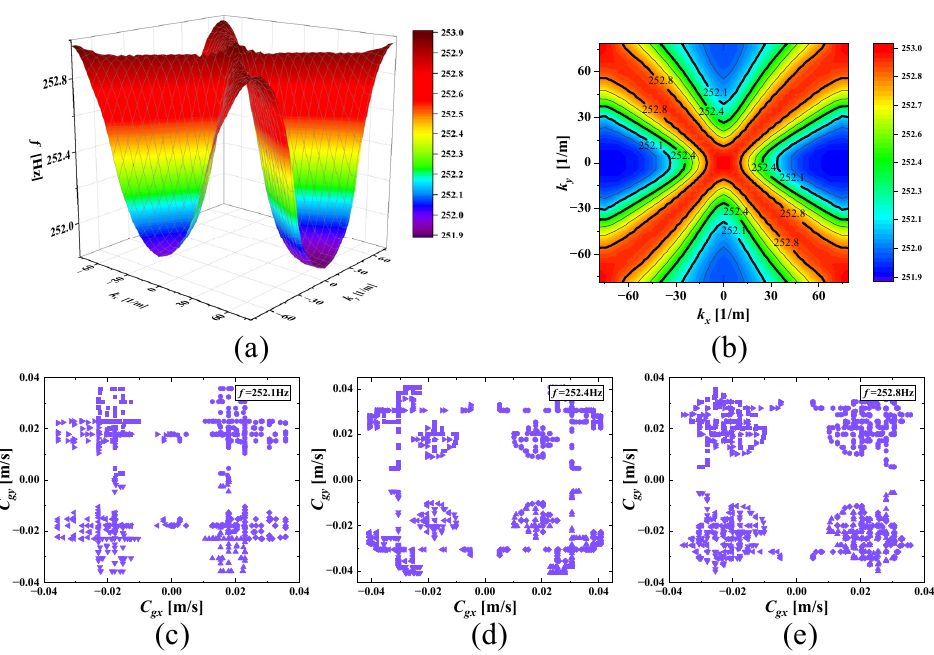
Figure 11. ( a ) Eighth mode; ( b ) ISO-frequency contours; ( c – e ) group velocity of eighth wave mode at 252.1 Hz, 252.4 Hz, and 252.8 Hz.